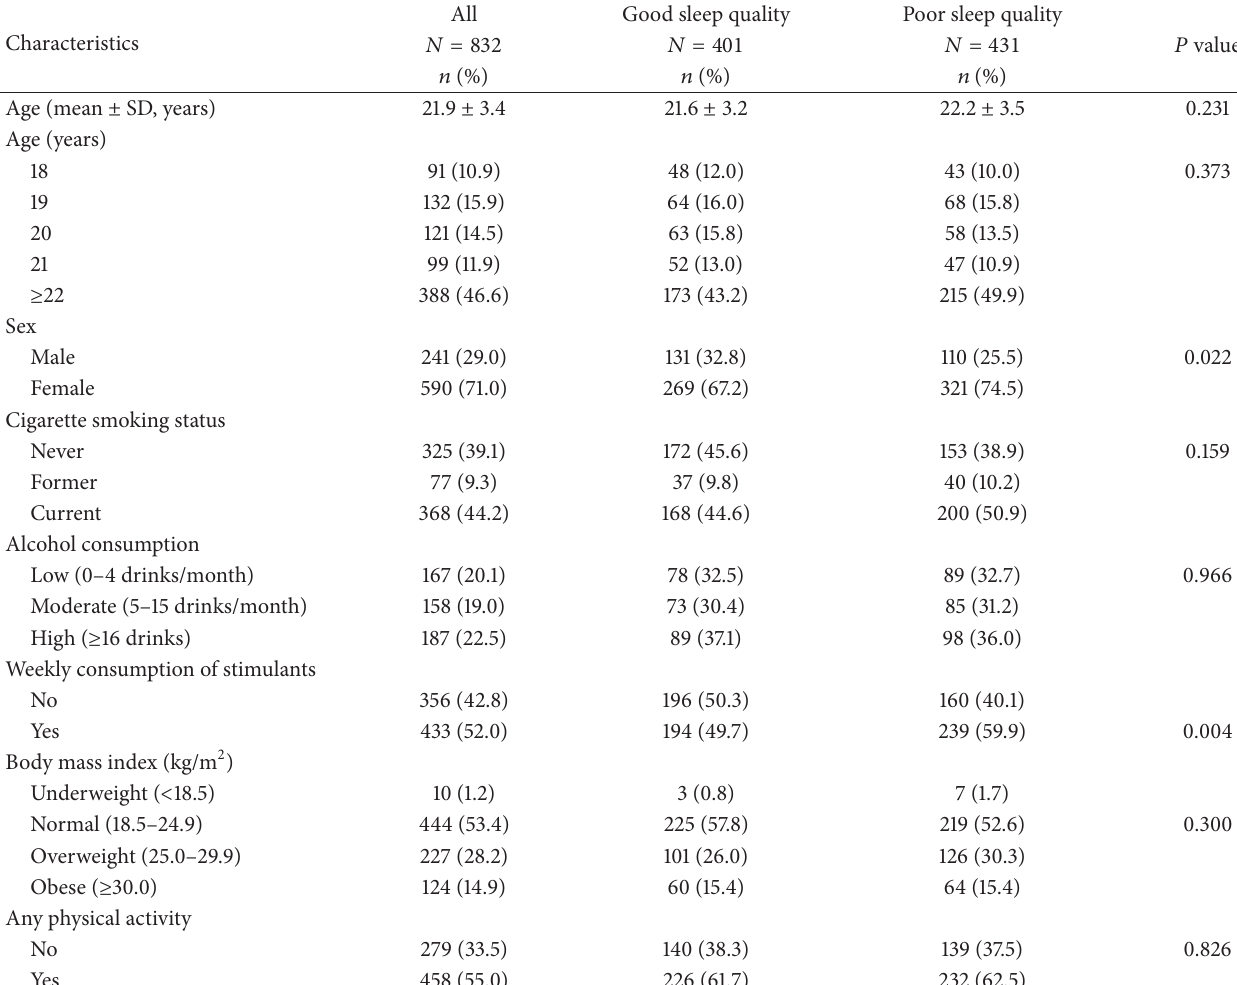
Table 1: Characteristics of the study